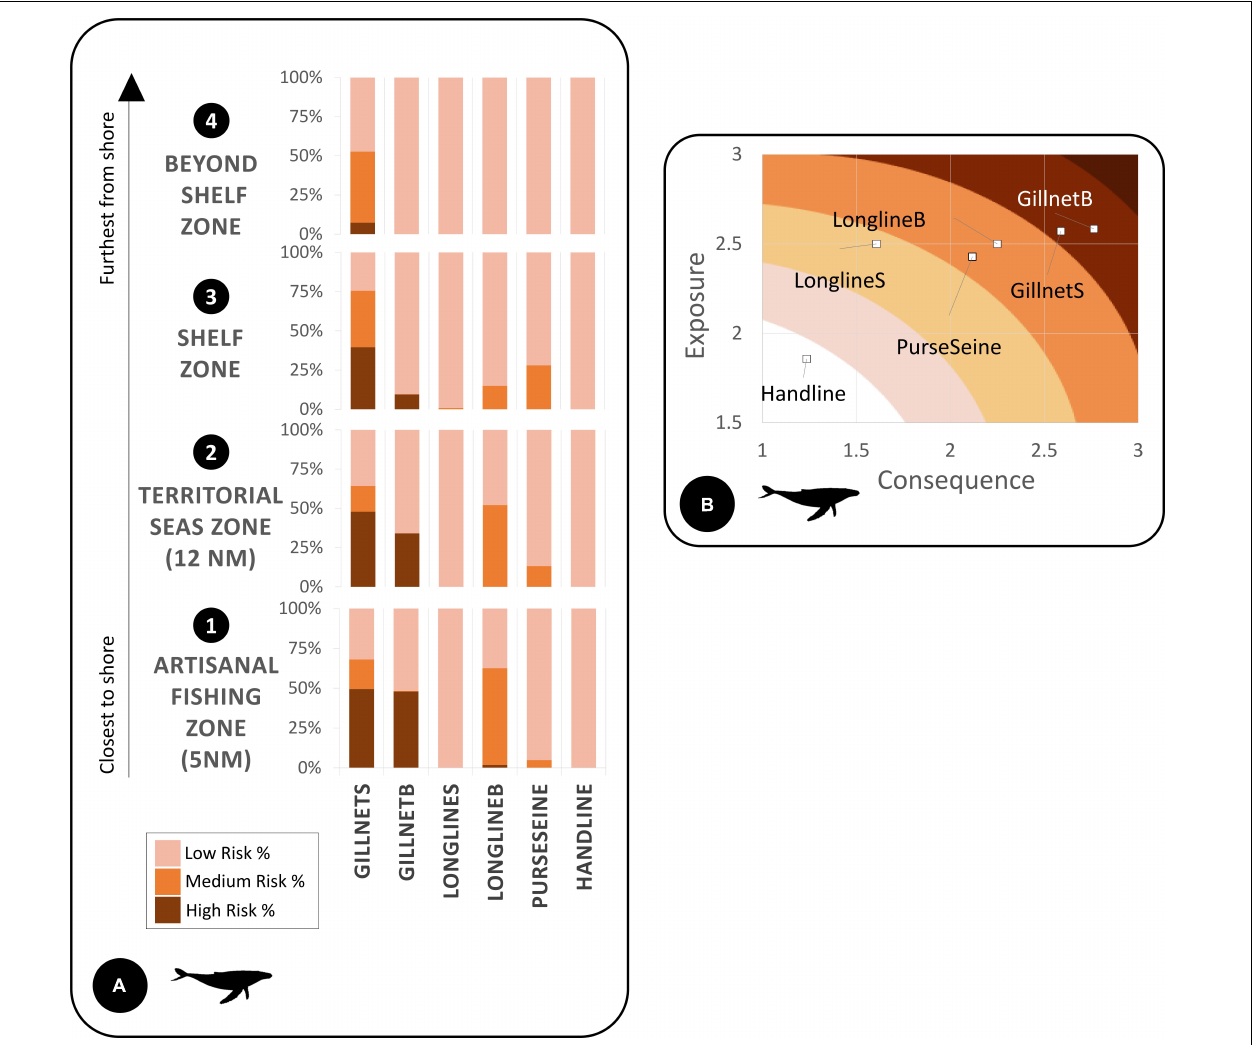
FIGURE 4 | (A) We calculated humpback whale bycatch risk percentages for each subzone by gear type divided into low, medium, and high risk. (B) Exposure and consequence plots depict gear impact on species based on the spatial exposure or consequence criteria ratings ( Supplementary Material